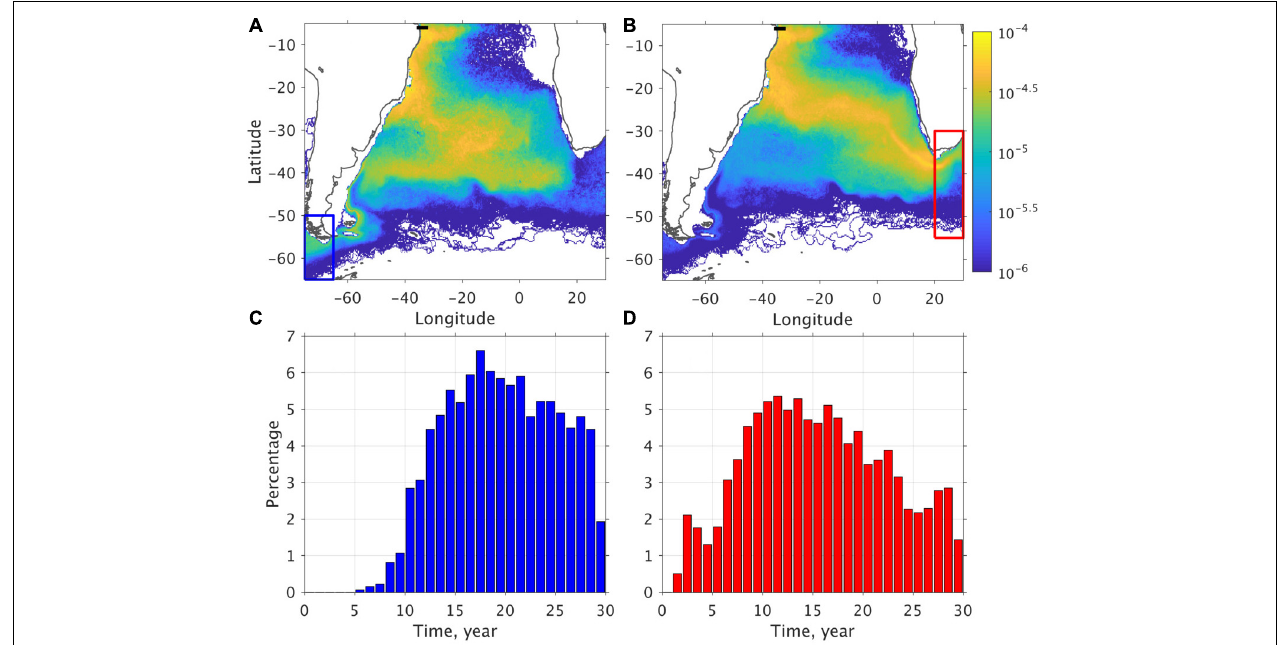
FIGURE 12 | (A,B) Probability map of the trajectory occurrence in the South Atlantic (1/4 ◦ × 1/4 ◦ grid) for the AAIW particles that were released along 6 ◦ S in the North Brazil Current (thick black line) and back-tracked for 30 year to reach (A) blue box in the Drake Passage (3,166 particles) and (B) red box in the Agulhas Leakage (7,167 particles); (C,D) the percentage of the particles that were back-tracked to reach (C) the Drake Passage and (D) the Agulhas Leakage as a function of time. The probabilities are computed as the number of particles landing in 1/4 ◦ x1/4 ◦ box normalized by total number of particles over